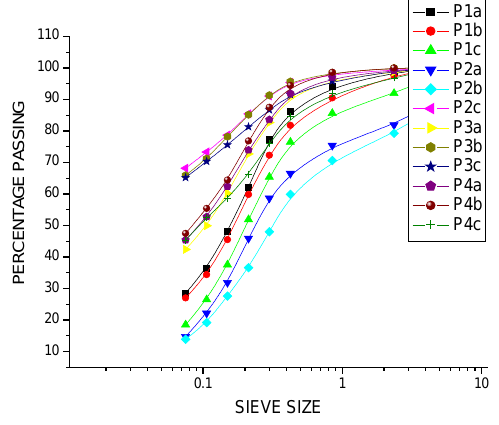
Figure 4: Grain Size Distribution Curves of the Soil Samples Soils with shrinkage limits of less than 5 are of believed to be of good resistance to shrinkage, between 5 and 10% are of medium resistance, 10 and 15% are poor while less than 15% are of very poor resistance to shrinkage. This shows that in terms of resistance to shrinkage, Pit 1, Pit 2 and Pit 4 soils are of poor resistance to shrinkage while soils of Pit 3 (average, 8.46) is of medium resistance to shrinkage. The lower the shrinkage limit, the better the soil as material for cemetery